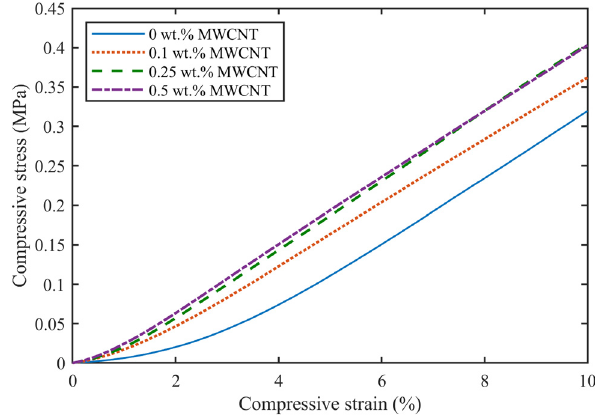
Figure 5: Compressive stress vs compressive strain graphs for